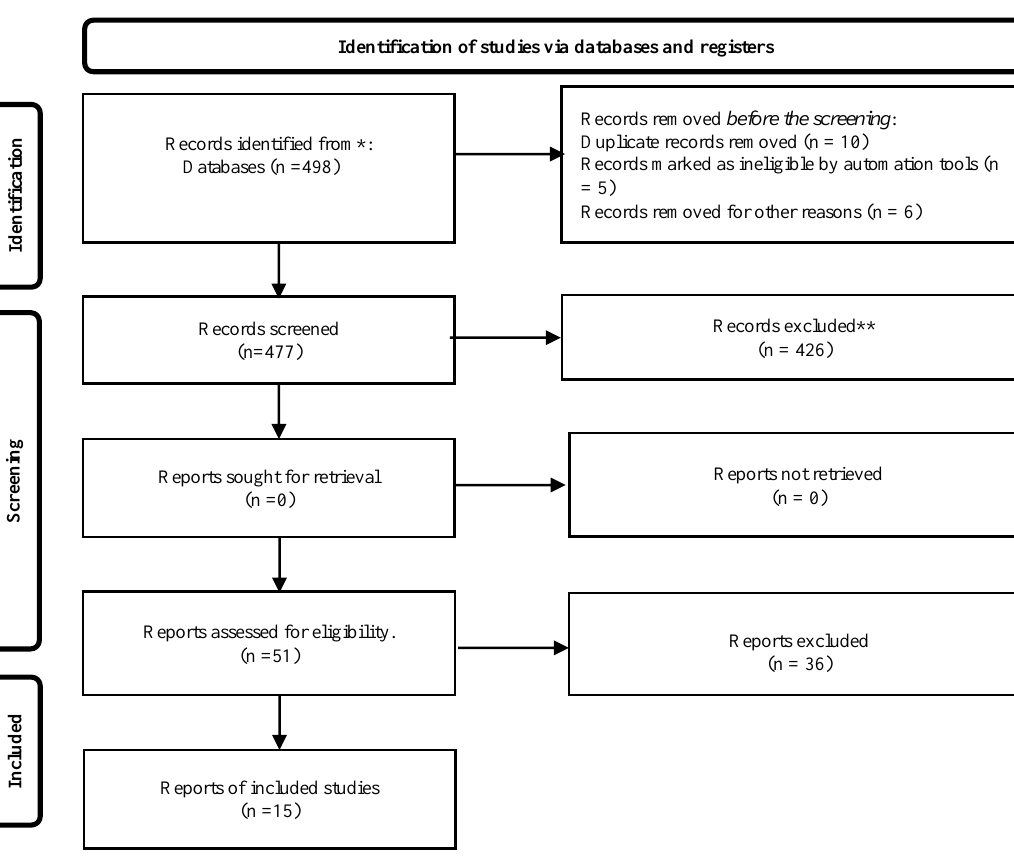
Fig. 1. PRISMA 2020 Checklist.